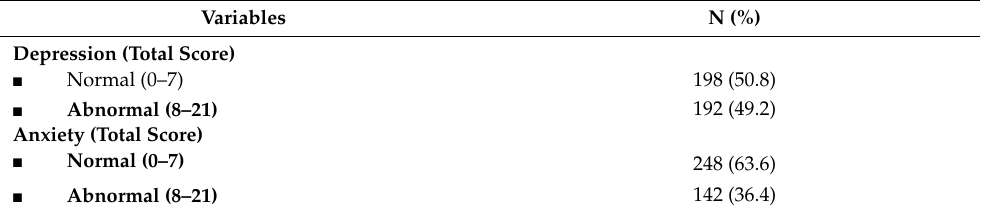
Table 3. Distribution of total scores of Hospital Anxiety and Depression among patients with CRD N = 390.